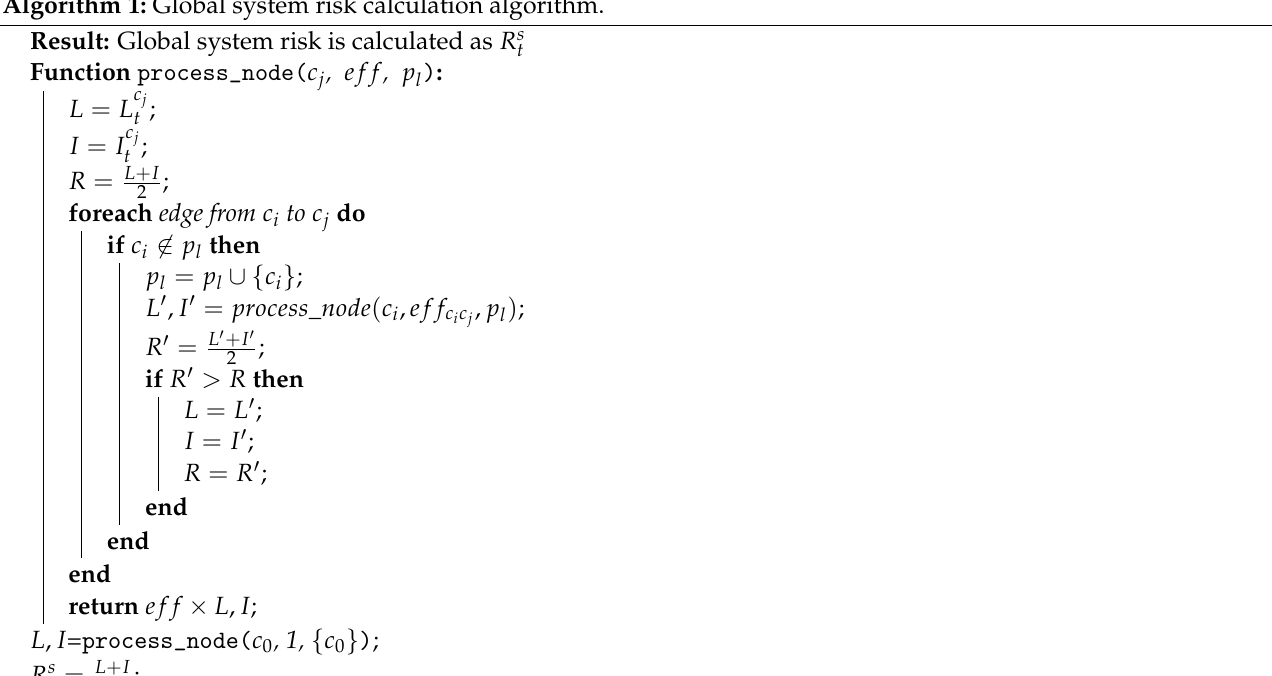
Algorithm 1: Global system risk calculation